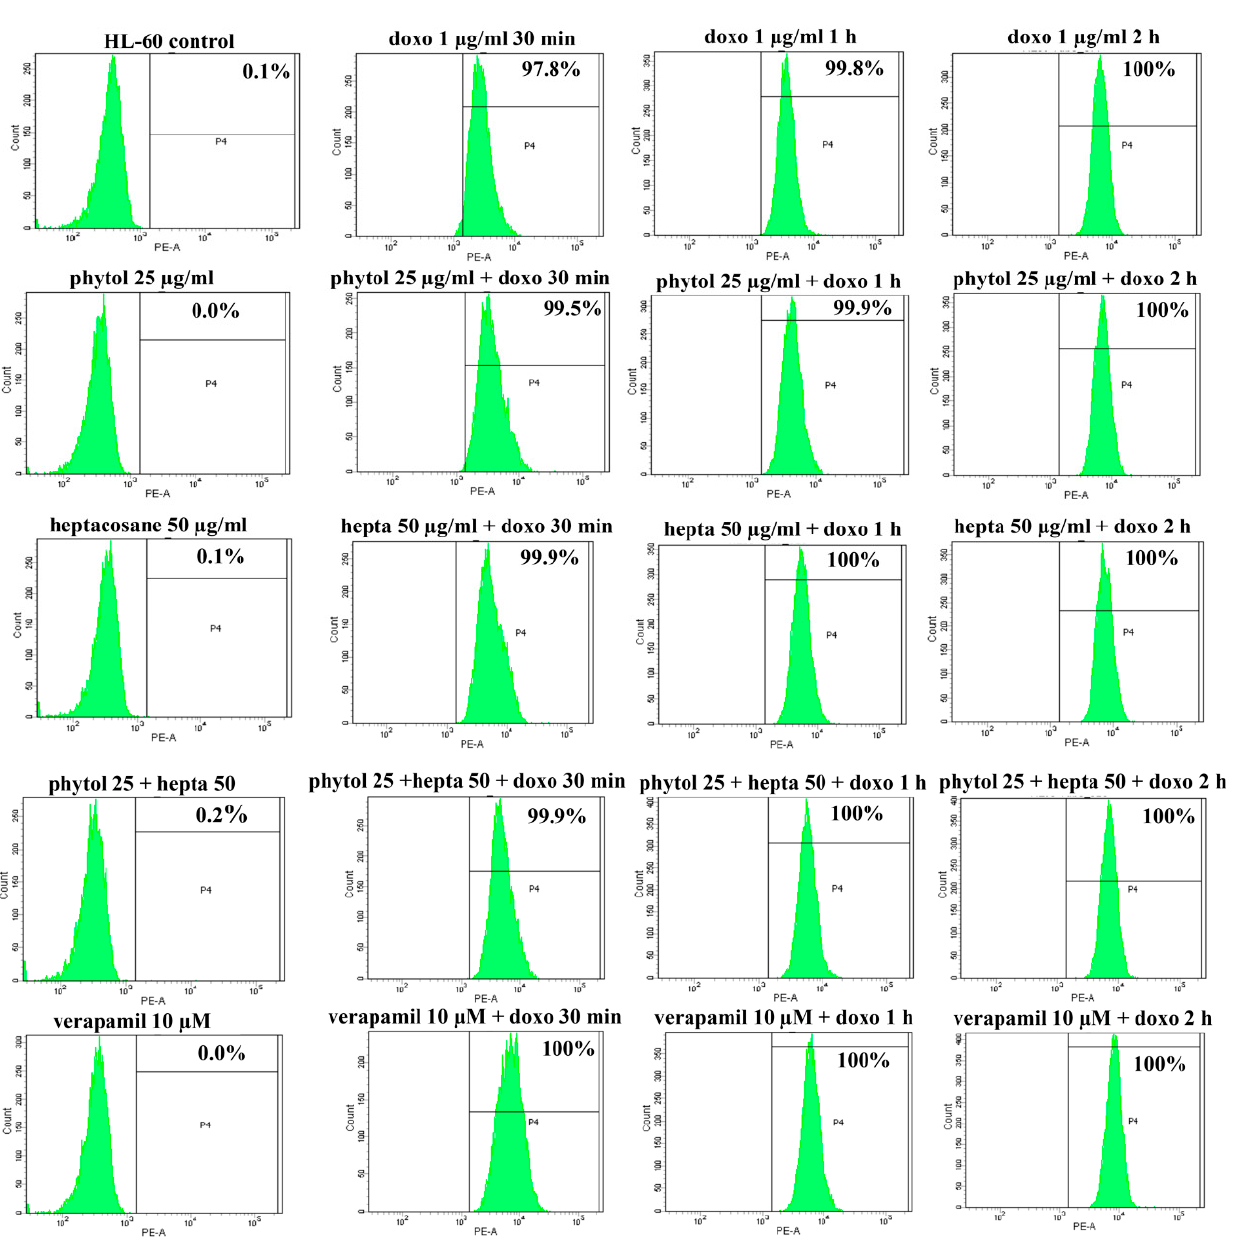
Figure 7. Effects of phytol and heptacosane on intracellular accumulation of doxorubicin in HL-60 cell line. Representative example of flow cytometry analysis of intracellular accumulation of doxorubicin (doxo; 1 µg/mL) after different times of incubation (30 min, 1 h and 2 h) in HL-60 cells pre-treated with phytol (25 µg/mL), heptacosane (hepta; 50 µg/mL), alone and in combination, or verapamil 10 µM for 24 h.